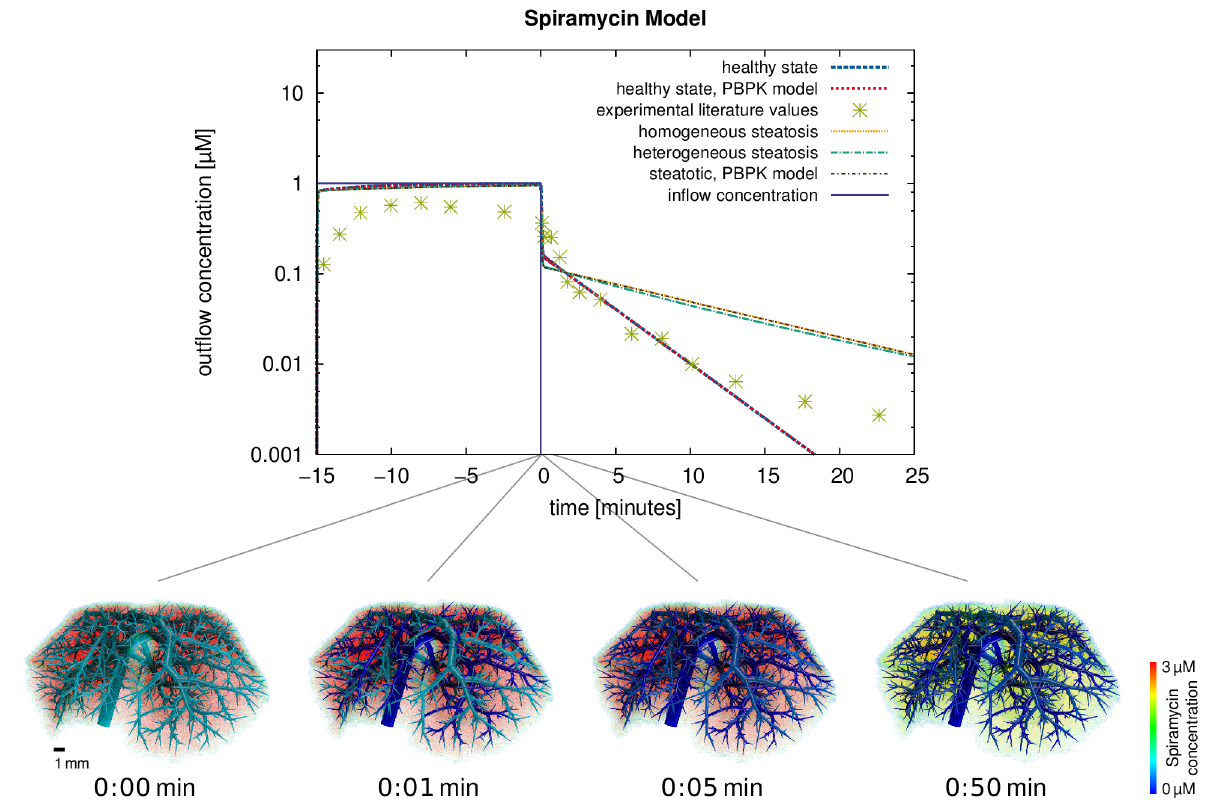
Figure 10. Results for the metabolization of spiramycin and comparison to experimental data from an isolated perfused liver. The plot shows the outflow rates of spiramycin from our single pass perfusion model for a spiramycin inflow during 15 minutes compared to experimental data from an isolated perfused liver [32]. While the experimental values were measured in a healthy liver, we also show simulation results for the steatotic states. The volume renderings show the total spiramycin concentration for four time points after the end of the inflow ( t ~ 0 minutes).